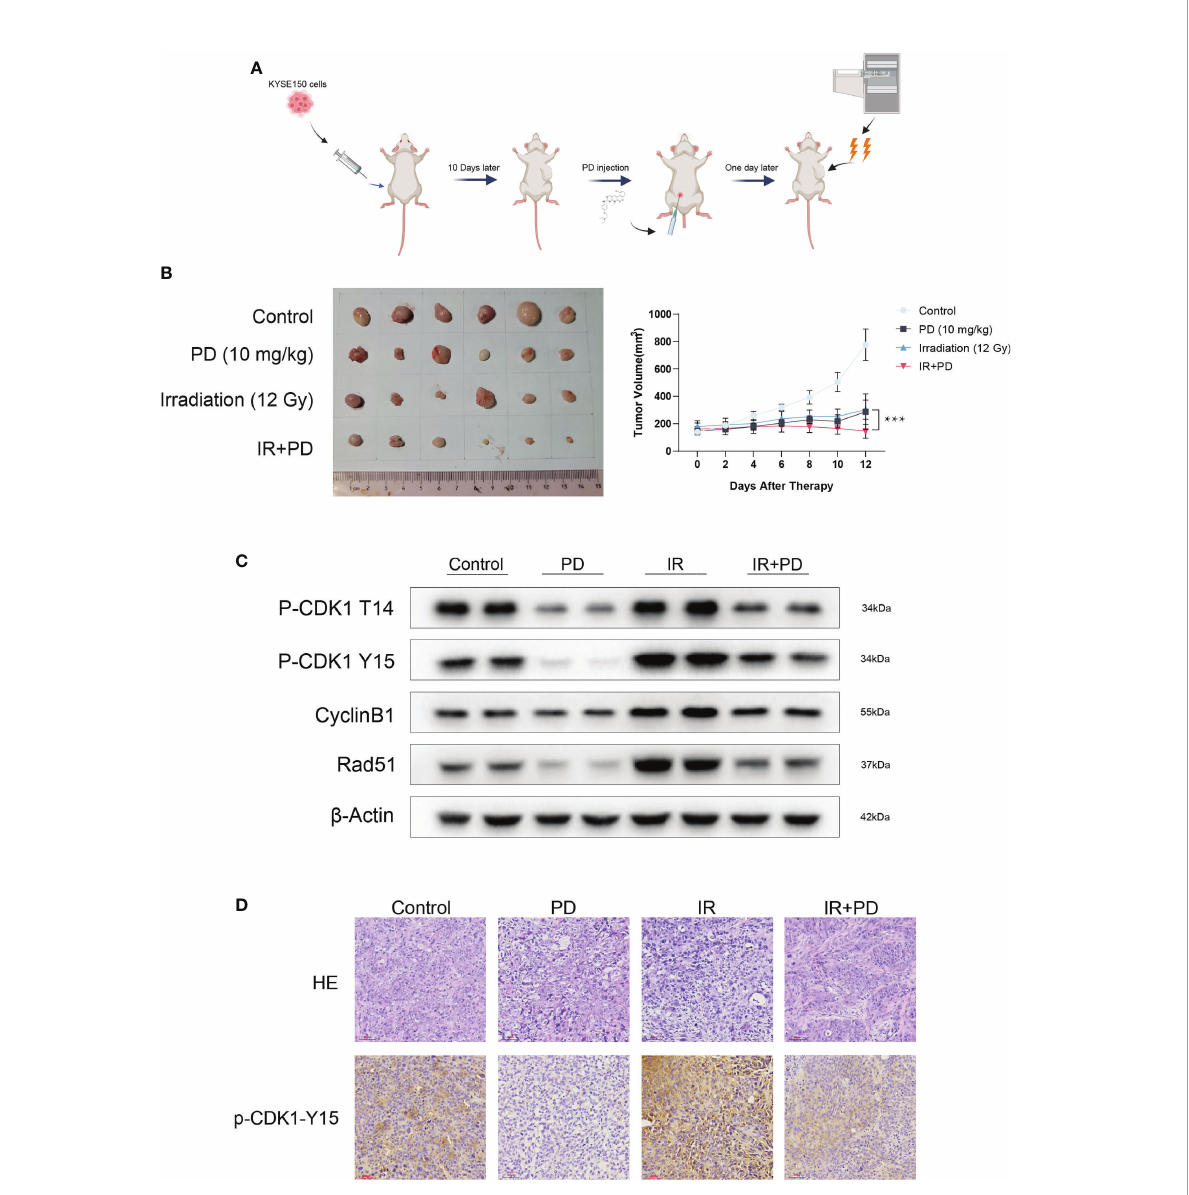
FIGURE 8 PD is effective with irradiation in vivo . (A) Schematic diagram of PD and irradiation combination therapy (created by BioRender). (B) Combination therapy inhibits tumor growth in vivo . (C) PD inhibits the function of WEE1 and PKMYT1 in vivo . (D) IHC shows PD inhibits the expression of p-CDK1-Y15 in vivo . Scale bar = 60 m m (D) . ***P < 0.001